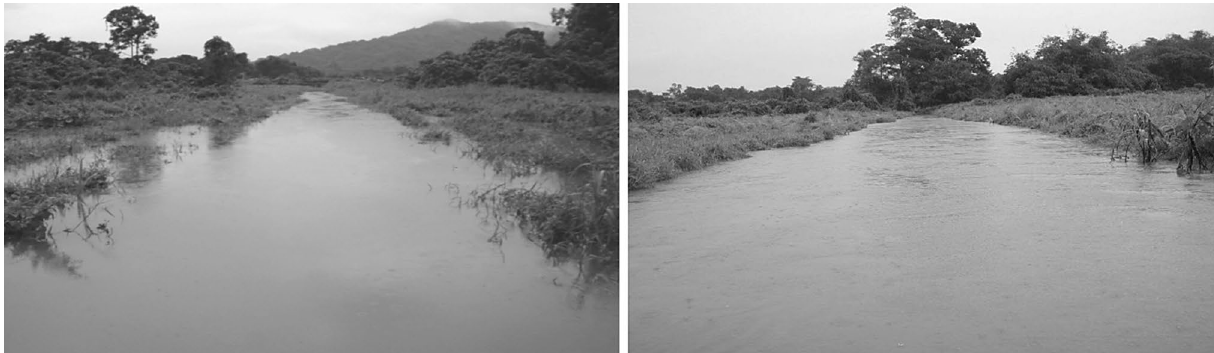
Fig. 16 Morphological cross section of river Senggi (B) and river Senggai (Hin et al. 2008) Fig. 17 Actual cross section of river Senggi